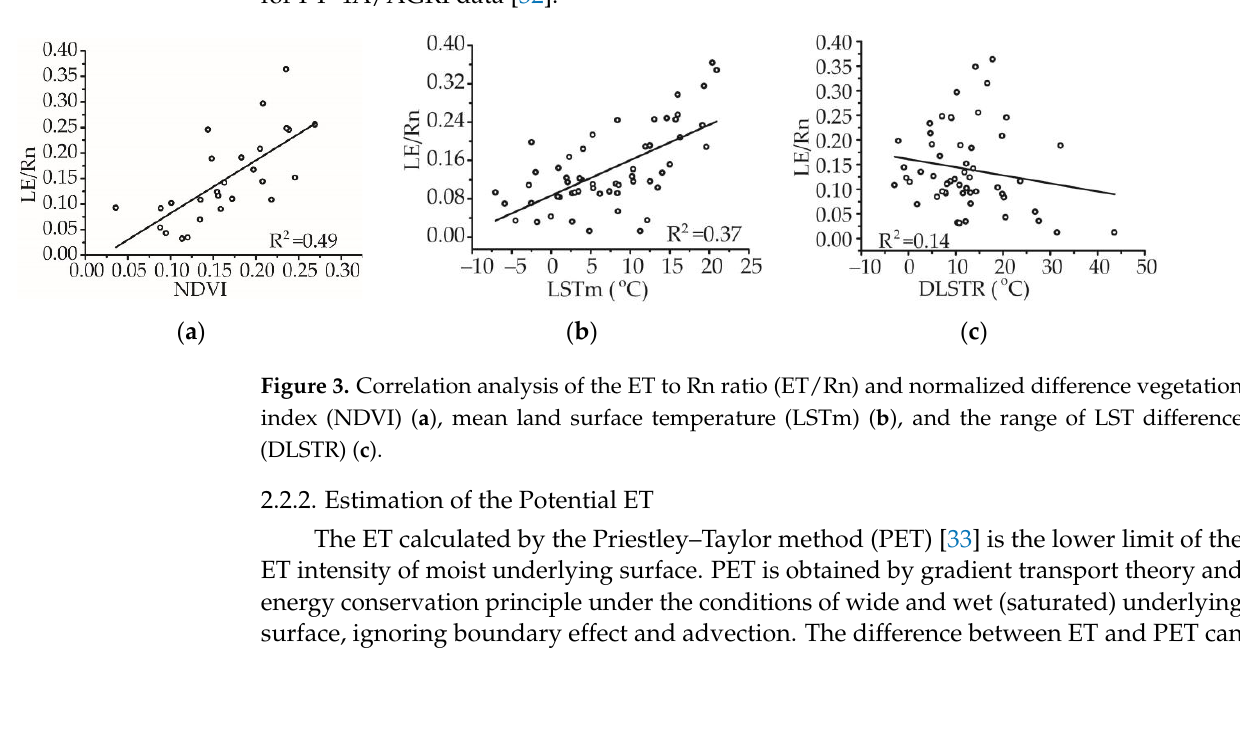
Figure 2. Valid data filtering, in which the red dotted line is used to distinguish the data between stations. In the lower abscissa, the interval between two scales is one year.